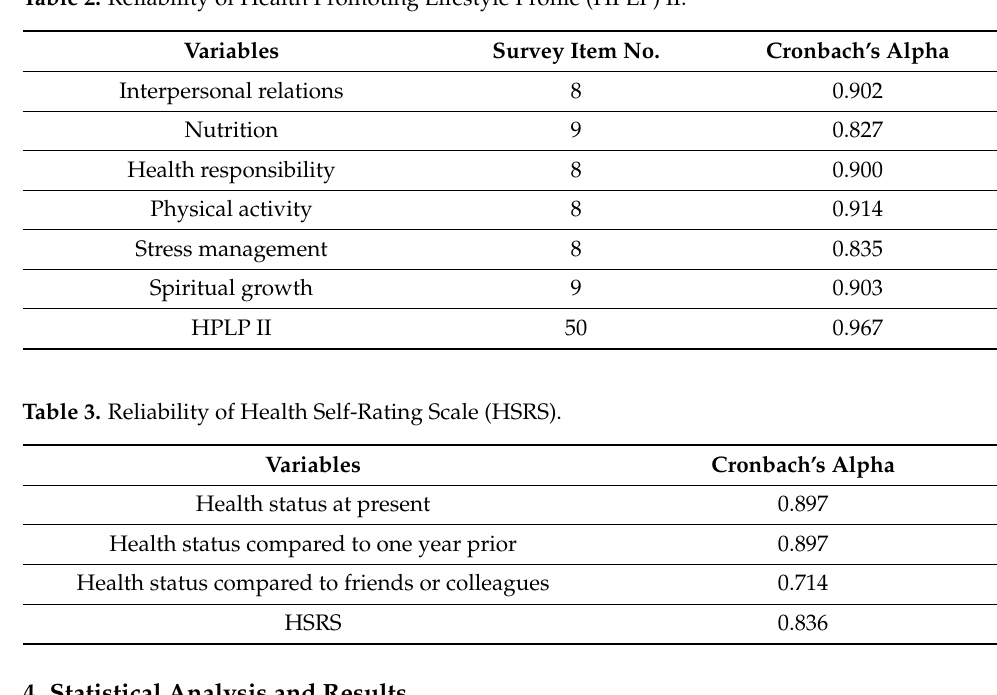
Table 2. Reliability of Health Promoting Lifestyle Profile (HPLP) II.